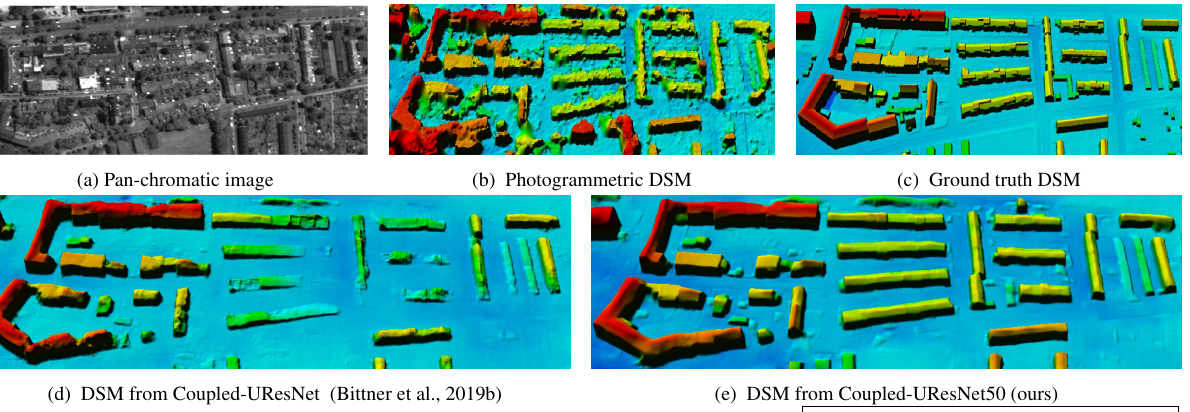
Figure 6. Detailed visual analysis of DSMs, generated by (d) Coupled-UNet cLSGAN with fixed balancing hyper-parameters (Bittner et al., 2019b) and (e) the proposed Coupled-UResNet50 in comparison to (c) referenced surface model over selected Munich area. (a) and (b) depict the initial PAN and DSM images, respectively. DSM images are color-shaded for better